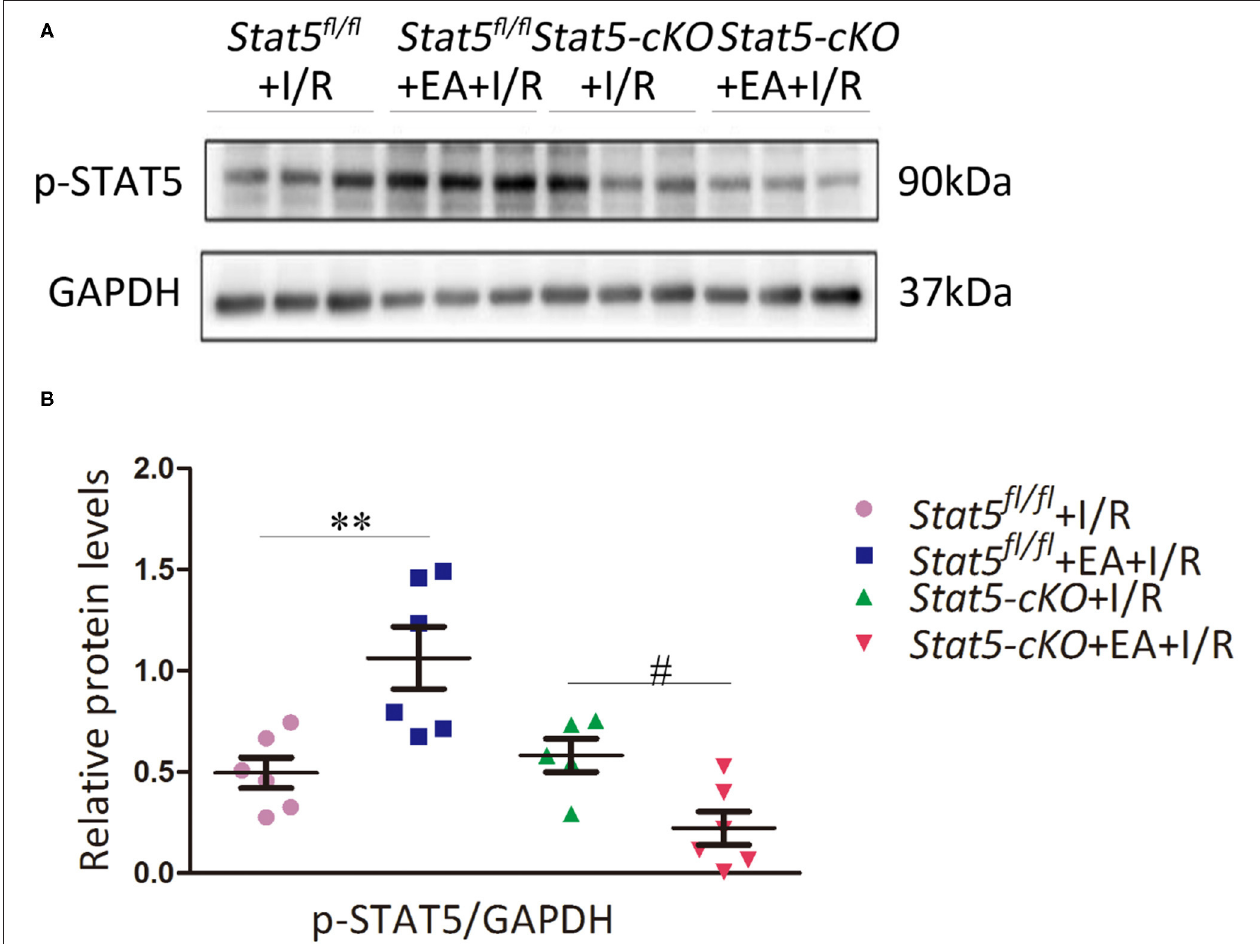
FIGURE 3 | Electroacupuncture pretreatment (EAP) activated the STAT5 protein in the heart tissues of Stat5 fl / fl mice, but not in those of Stat5- cKO mice. (A) Representative western blotting images. (B) Quantitative analysis of p-STAT5 protein levels in each group. Data are presented as means ± SEM of at least three independent experiments. ** P < 0.01 compared with the Stat5 fl / fl + I/R group; # P < 0.05 compared with the Stat5- cKO + I/R group. Data were analyzed by two-way ANOVA with Bonferroni’s multiple comparison test, n =